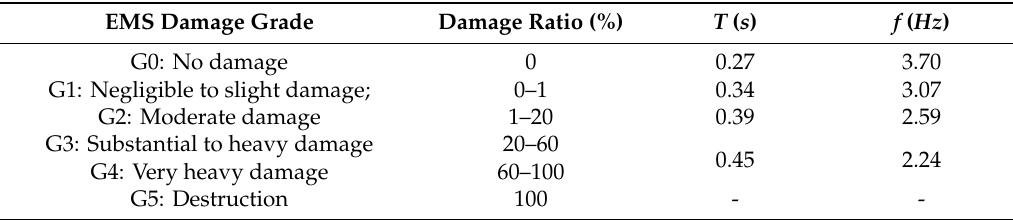
Table 4. Classification of damage grades according to the EMS-98 and estimation of the fundamental period / frequency of the “La Viña” building as function of the damage